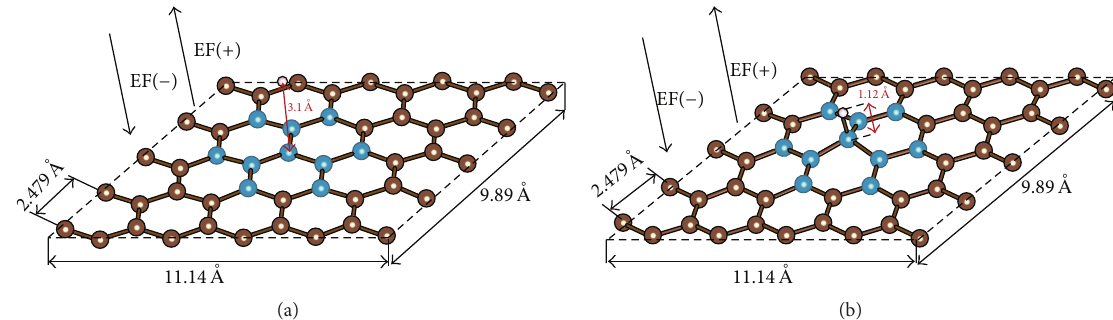
Figure 1: Structural parameters of the graphene supercell, with the two directions of the electric field (EF), for physisorption (a) and chemisorption (b). The unconstrained carbon atoms are represented in